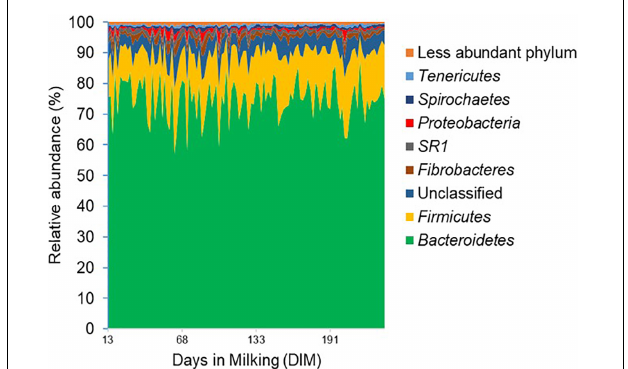
FIGURE 1 | Phylum level composition of the rumen bacterial community. Bacterial 16S rRNA gene profile is shown in the area of the graph and distinct phyla are indicated by different colors. The x -axis represents days in milking (DIM) of cows ranging from day 13 to day 320 and the y -axis represents the relative abundance of bacterial